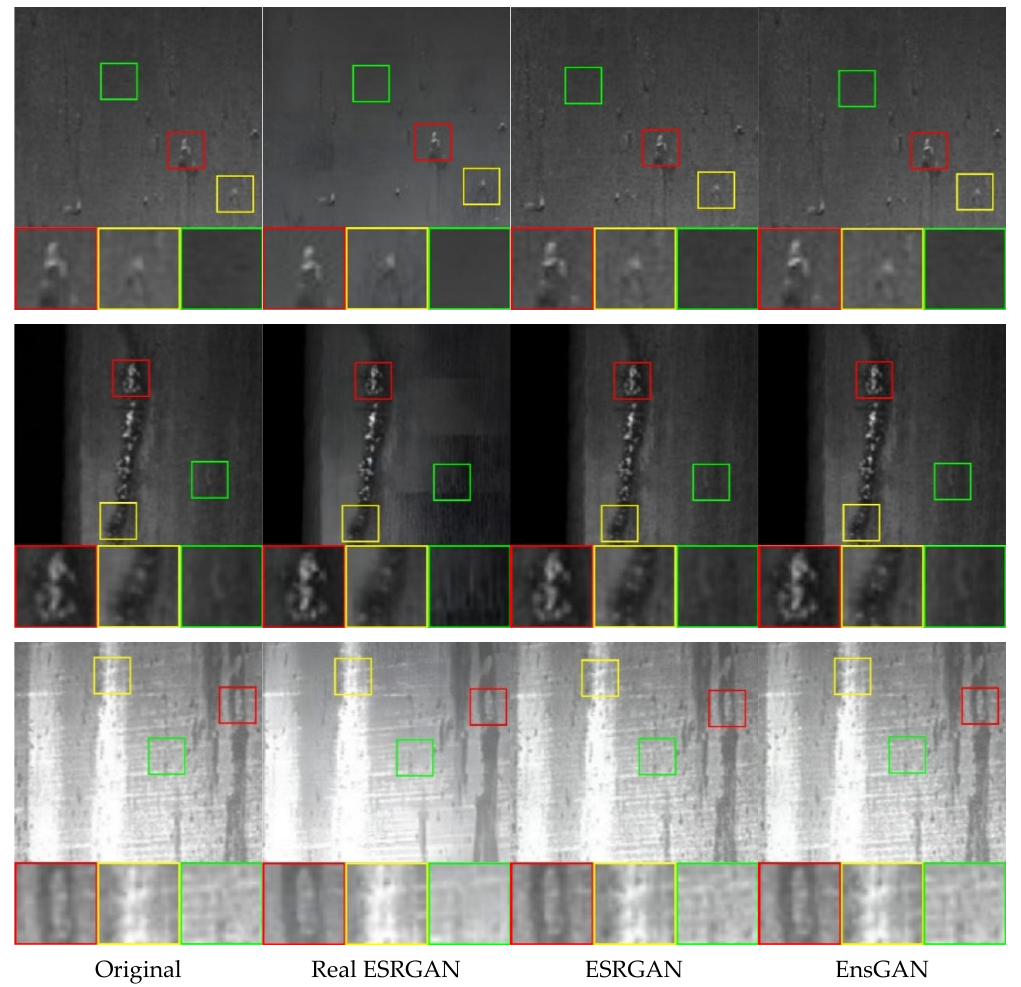
Figure 8. From left to right (zoom in for the best view): the original image and the generated image produced by Real ‐ ESRGAN, ESRGAN, and the proposed EnsGAN, respectively. The red and yellow boxes show that the proposed EnsGAN does a better job of improving the resolution quality of the defect region. Moreover, the green box shows that the proposed method has better noise reduction on the original images and attains a smoother texture than ESRGAN does. Table 1. Comparison of Real ‐ ESRGAN, ESRGAN, and proposed EnsGAN for PSNR results on three sample images from the Severstal steel defect dataset. The defect samples in these three images are shown in Figure 8 in the following order: the top is Image 1, the middle is Image 2, and the bottom is Image 3.